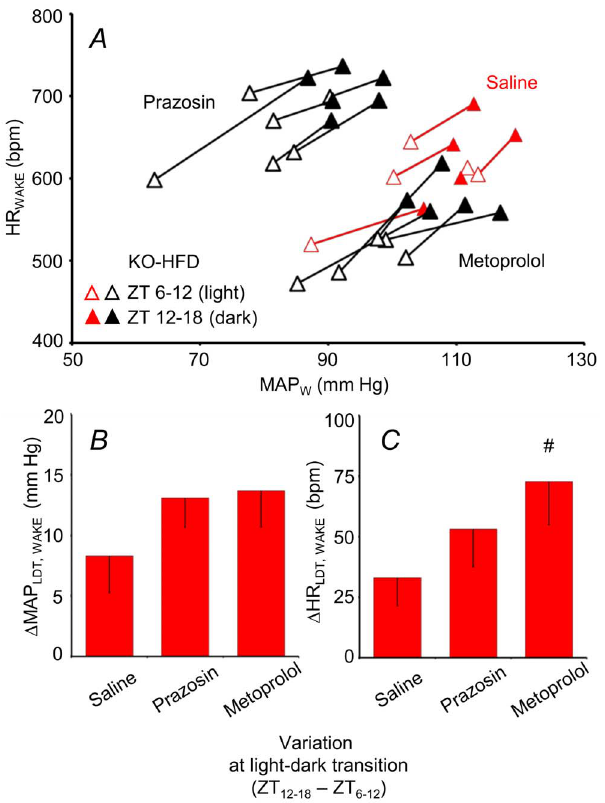
Figure 2. Cardiovascular effects of adrenergic receptor block- ade. Panel A shows mean values of MAP and HR during WAKE in a group of KO mice fed a HFD and subjected to pharmacological treatment with saline (vehicle, n=5), prazosin (a a 1 adrenergic receptor blocker, n=6) and metoprolol (a b 1 adrenergic receptor blocker, n=5) during both the light and dark periods. Segments connect the values measured in the same mouse after drug or vehicle injection during the light (open triangles) and dark (filled triangles) periods. Values of MAP and HR after prazosin and metoprolol formed two separate clusters and are shown in black and white. Values of MAP and HR after saline are shown in red and white. Panels B and C show means and SEM of D MAP and D HR during WAKE across the light-dark transition (LDT) for the same mice in A. # , P , 0.05, vs. saline. For other abbreviations, see Figure